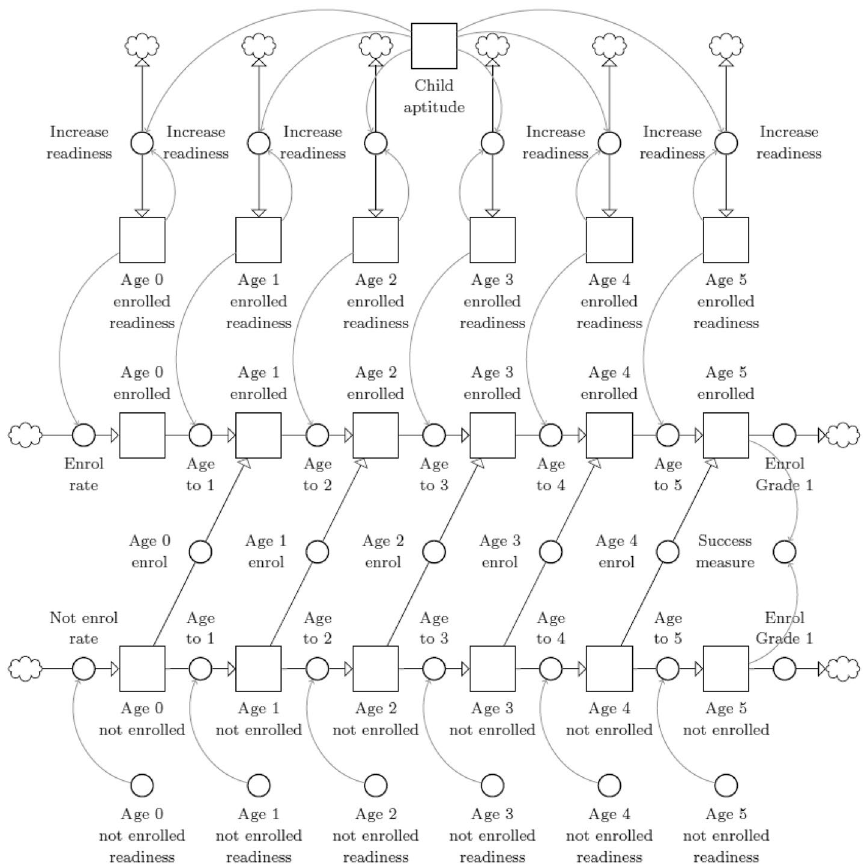
Fig. 3 Stock-and-flow diagram for child progression in the